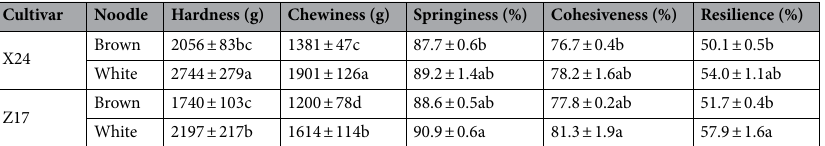
Table 4. Texture profiles of brown and white rice noodles processed from two rice cultivars, Xiangzaoxian 24 (X24) and Zhongjiazao 17 (Z17). Data are mean ± SE ( n = 3). Within a column, data sharing the same lowercase letters are not significantly different at the 0.05 probability